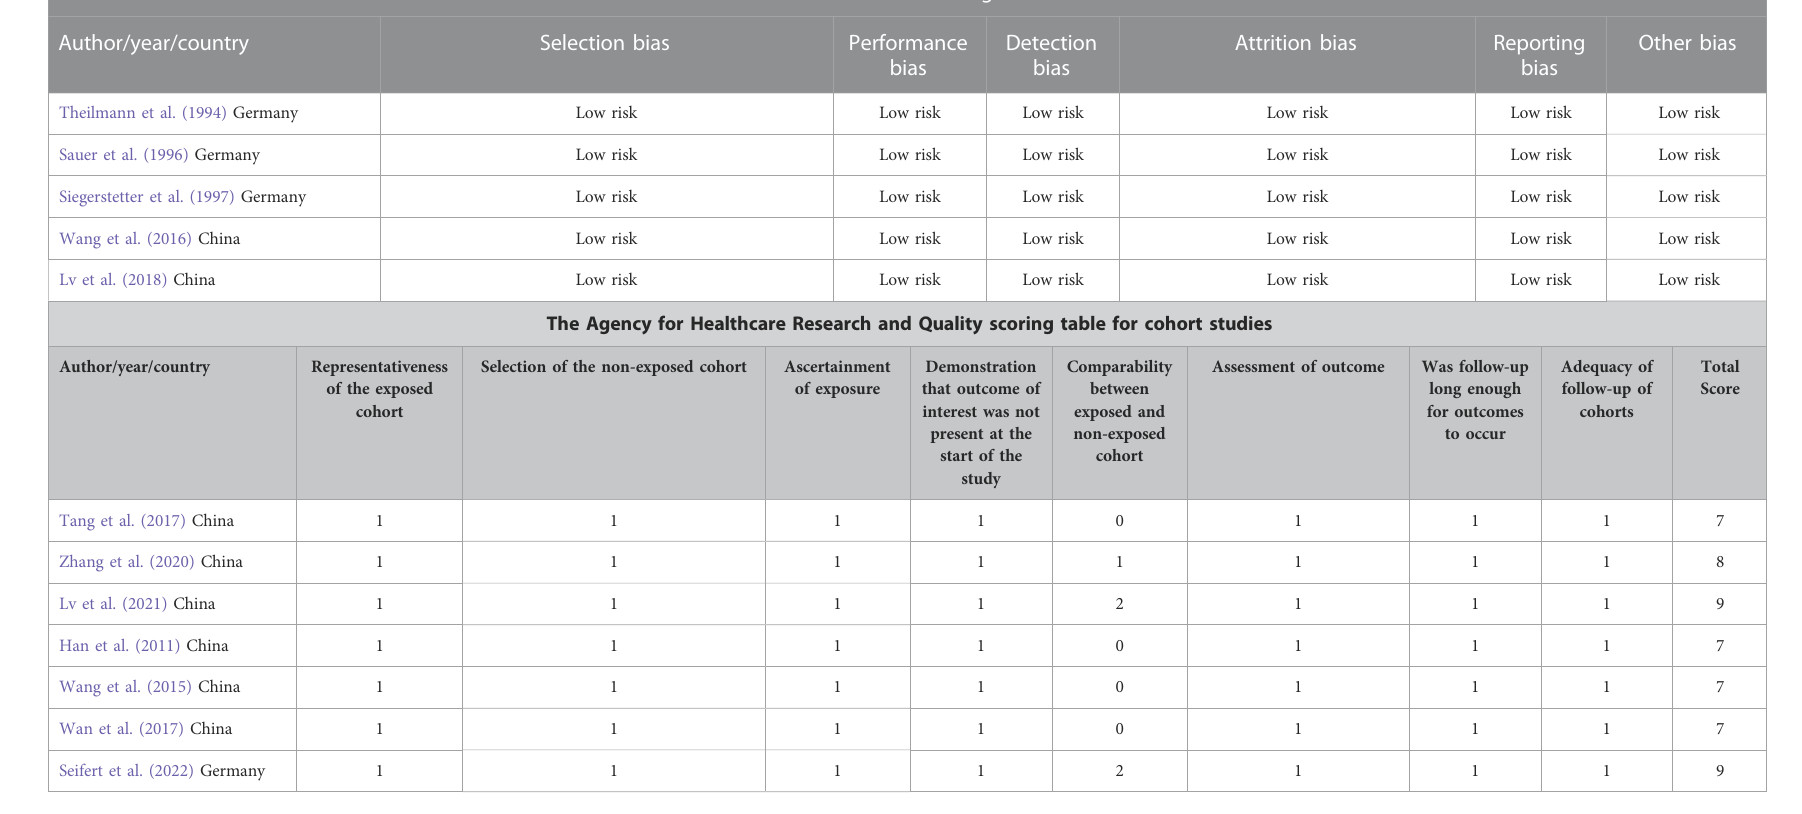
TABLE 1 Quality assessment for